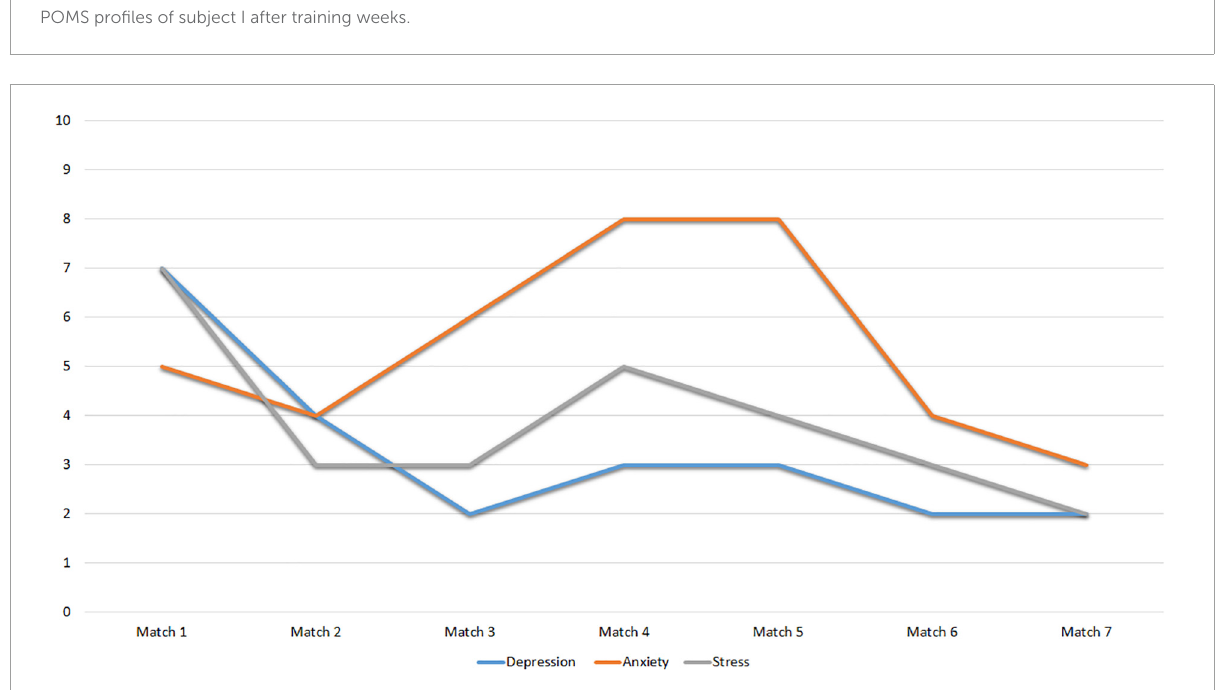
FIGURE4 Scores of subject 1 to the subscales of the DASS-21.